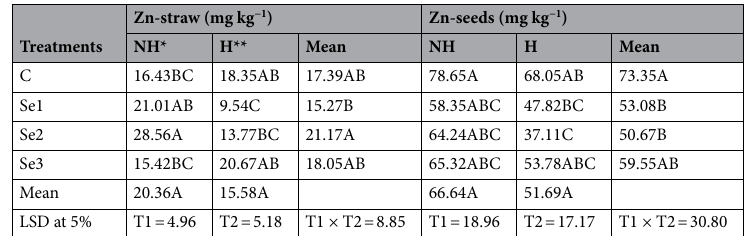
Table 11. Effect of Se and K-humate applications on Zn containing oat plant. *Refers to Se application without K-humate. **Refers to the simultaneous application of Se and K-humate.